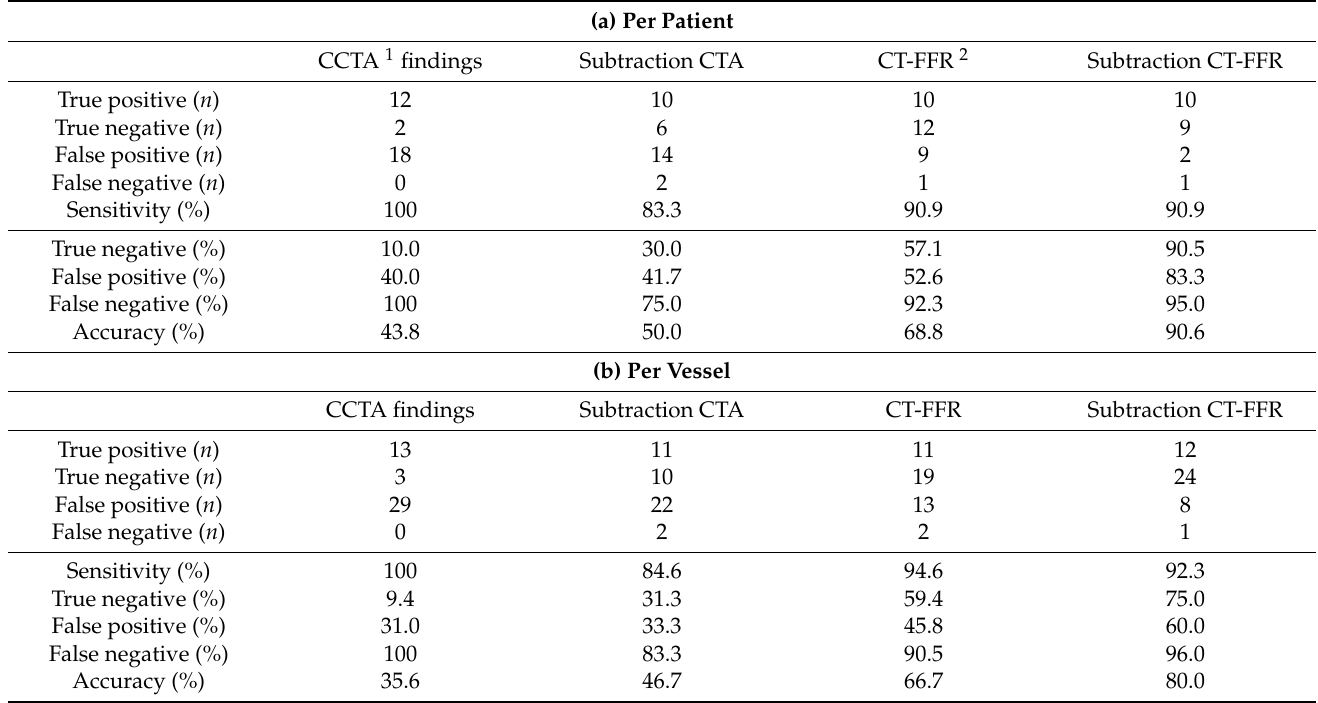
Table 3. Diagnostic accuracies of CCTA findings, CT-FFR, subtraction CCTA and subtraction CT-FFR on a per patient and per vessel